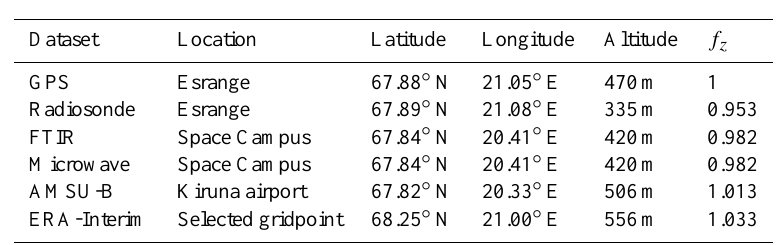
Table 1. Position (latitude, longitue, and altitude) of all datasets. The altitude is the starting altitude of the IWV measurement that we have assumed. Note that our AMSU-B data are areal averages, the position in the table is the center of the averaging area. For ERA-Interim, the selected grid point is the one closest to the GPS. The last column, f z , gives the correction factor that is applied to this dataset in order to account for the different altitudes, which is derived in Sect. 3.4. Note that the correct GPS receiver altitude is 469m as stated in Nilsson and Elgered (2008), but 470m is the value assumed in our analysis. Likewise, the actual ERA-Interim topology altitude is 557m, but we have assumed 556m. These small altitude differences have a negligible impact on the results.